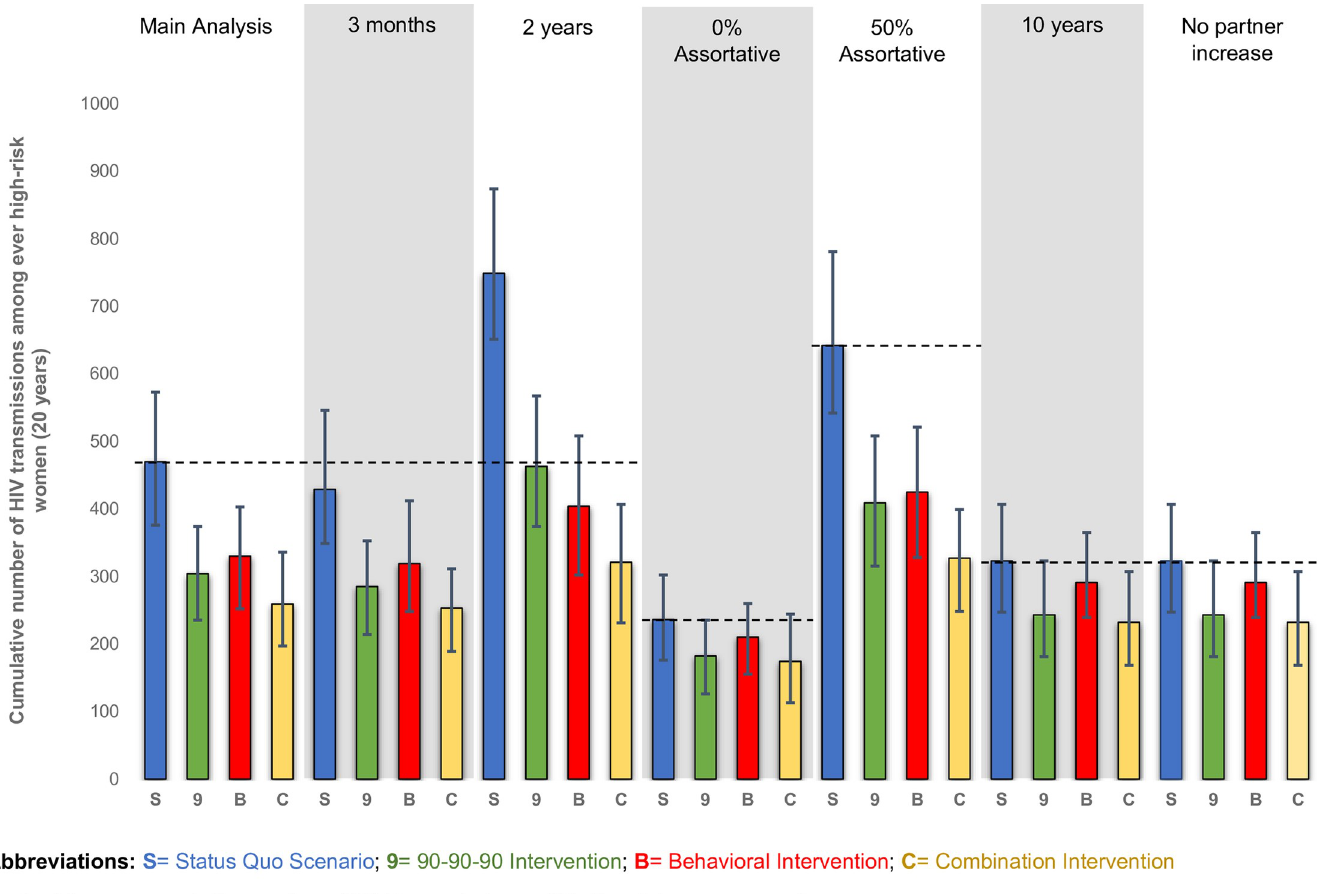
Fig 1. Cumulative number of HIV transmissions among African American women who experienced a partner’s incarceration.